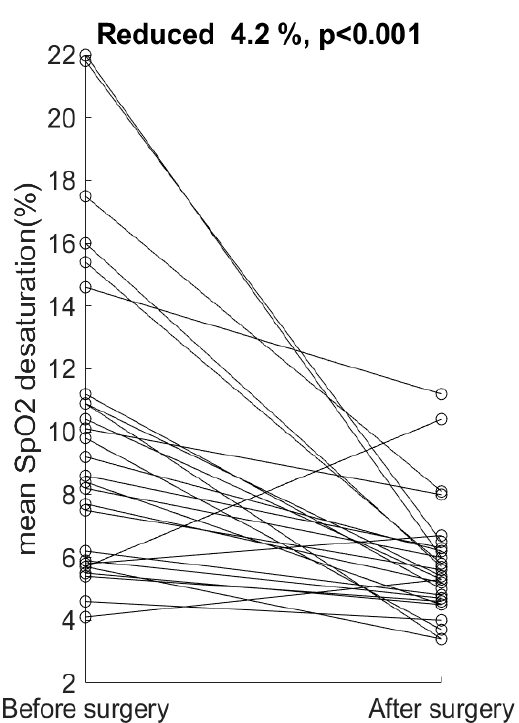
Figure 6. Individual change of mean SpO 2 desaturation. After the surgery, the mean desaturation severity reduced 4.2%, p < 0.001.